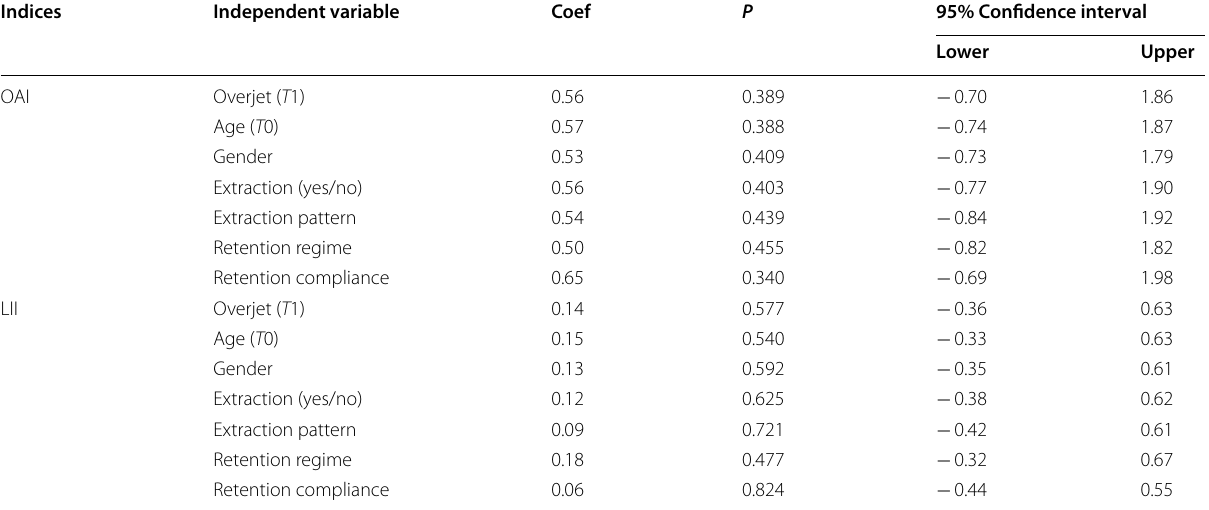
Table 4 Linear regression analysis of the effect of a residual overjet ( T 1) on post-treatment stability ( T 2) using the Orthodontic Alignment Index (OAI) and Little’s Irregularity Index (LII), adjusting for baseline alignment ( T 0) and confounding factors (Coef: coefficient)